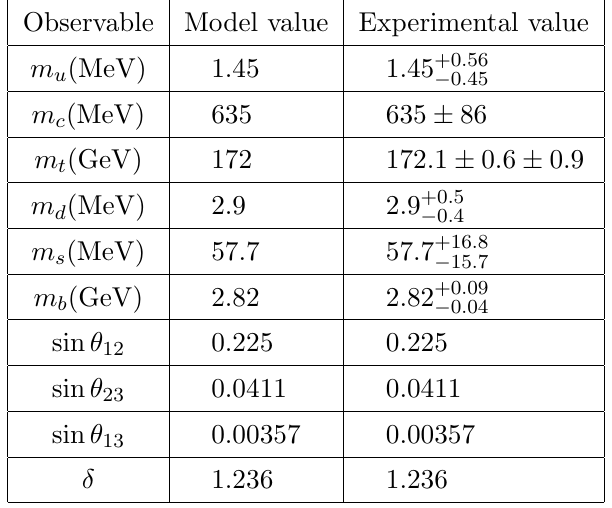
Table 4 . Model and experimental values of the quark masses and CKM